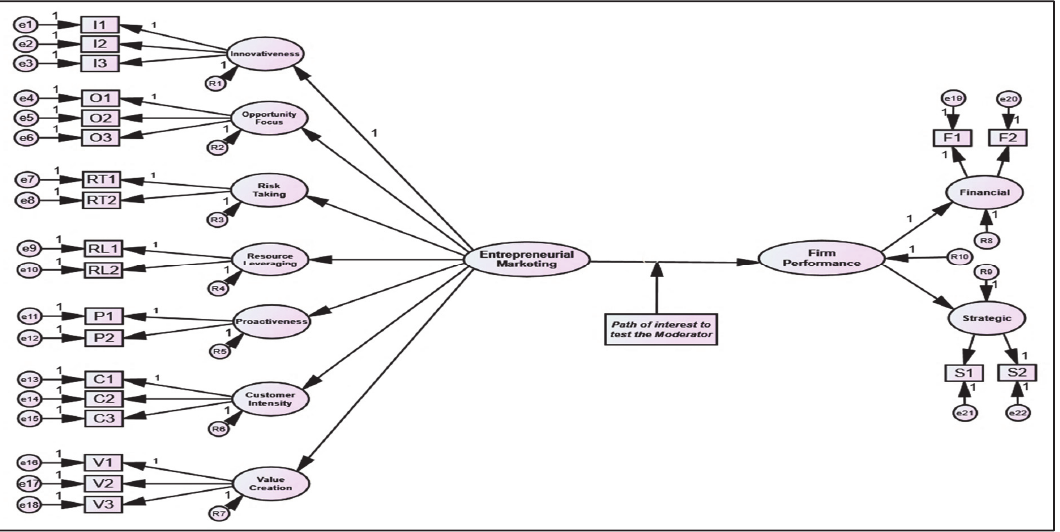
Fig. 4. Modelling the Moderator for Latent Construct